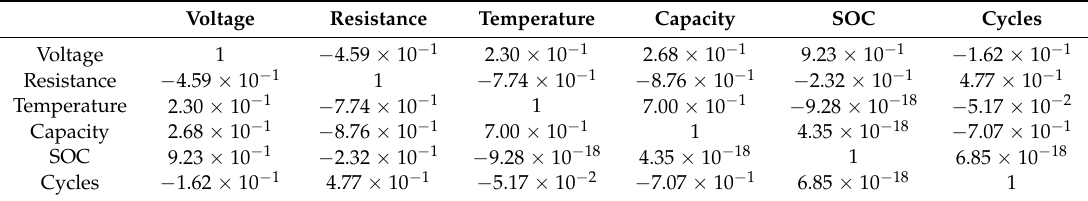
Table 1. Correlation coefficient between battery parameters.